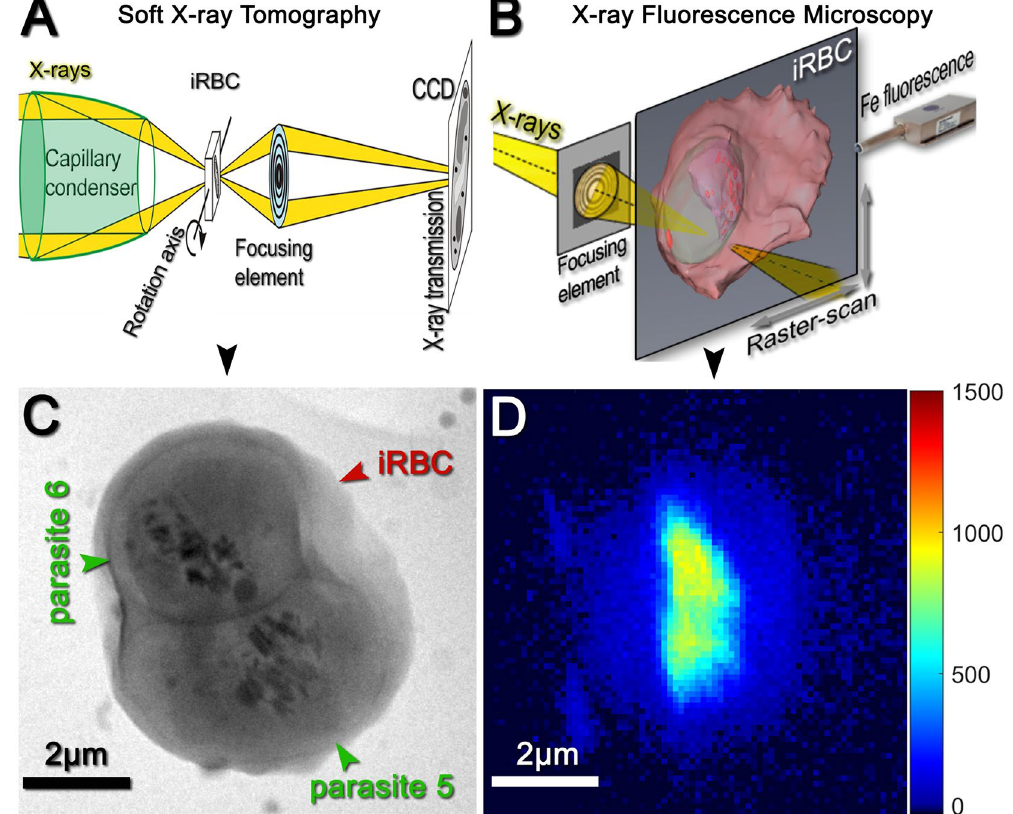
Figure 1. ( A ) Schematic view of soft X-ray tomography setup. ( B ) Schematic view of scanning X-ray fluorescence setup. ( C ) Non-aligned soft X-ray tomography image of a red blood cell (red arrow) infected with two malaria parasites (green arrows). ( D ) Non-aligned X-ray iron fluorescence map of the same cell obtained by raster scanning in X-ray fluorescence